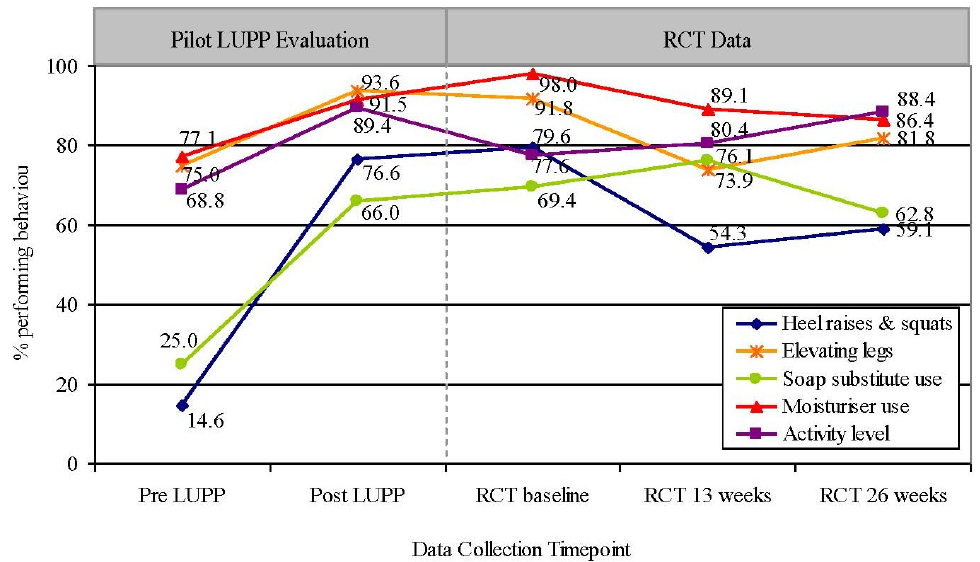
Figure 1. Client’s performance of health behaviors over